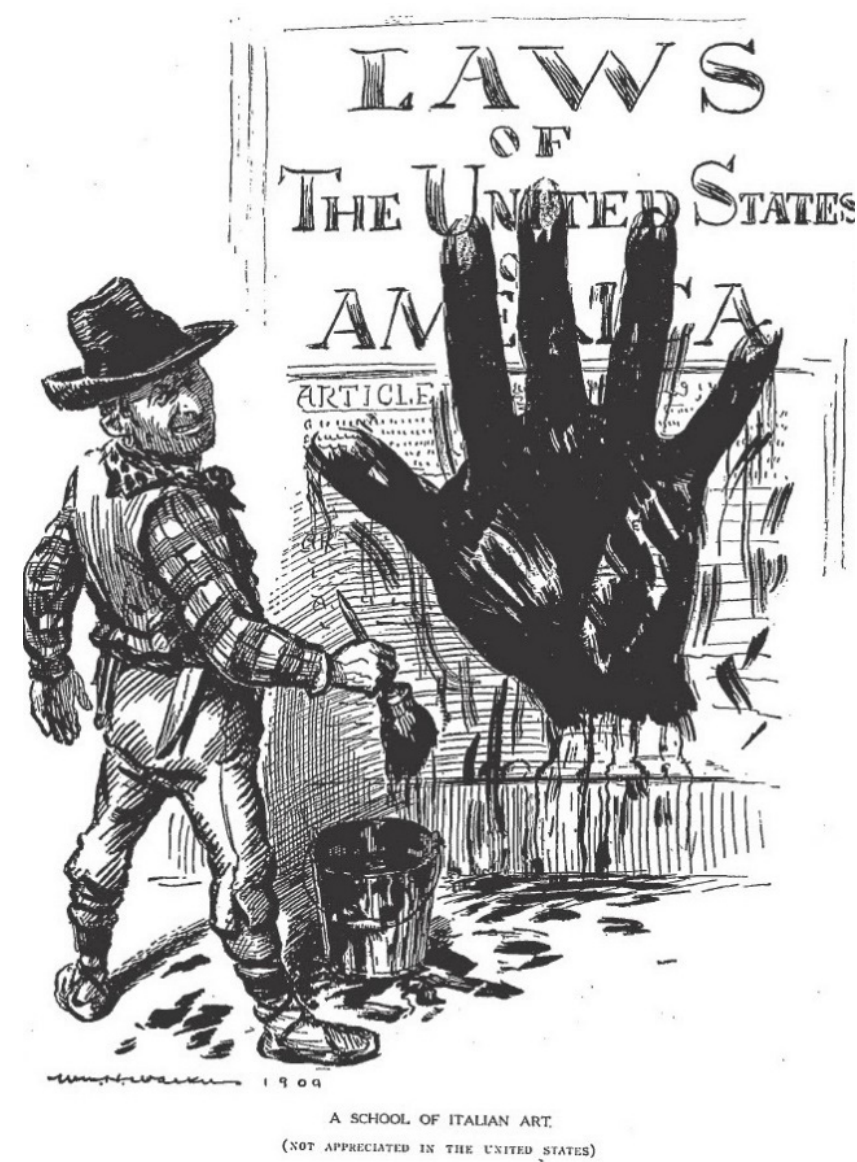
Figure 1. Life Magazine , 1 April 1909.